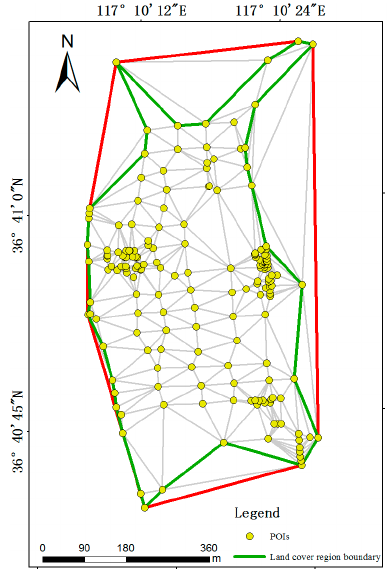
Figure 7. Region extraction using concave hull.